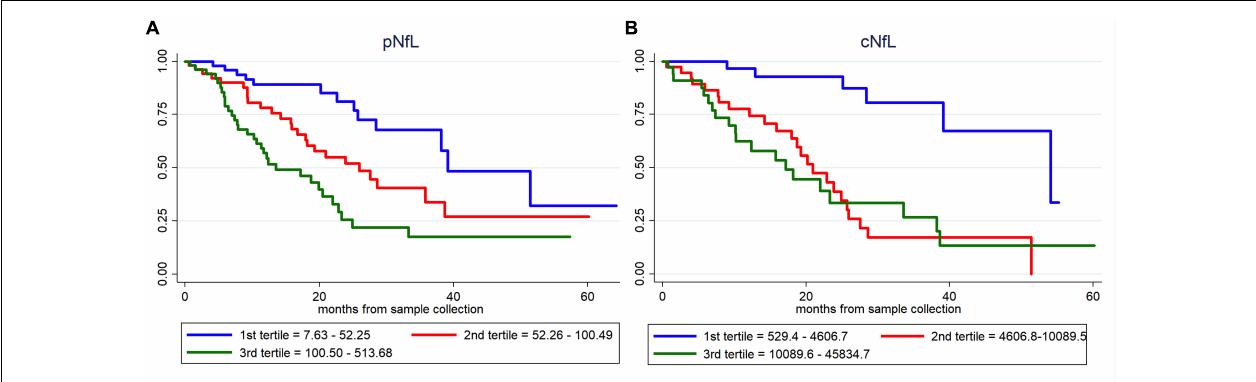
N pNfL Median (IQR)